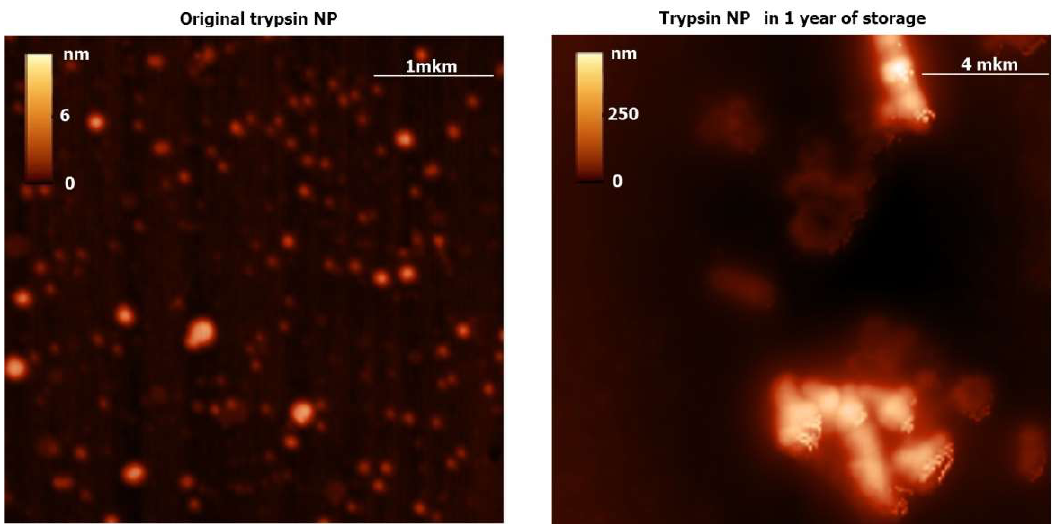
Figure 2. Atomic force microscopy (AFM) images of the original trypsin NP immediately after fabrication and in 1 year of storage at +4 °C.